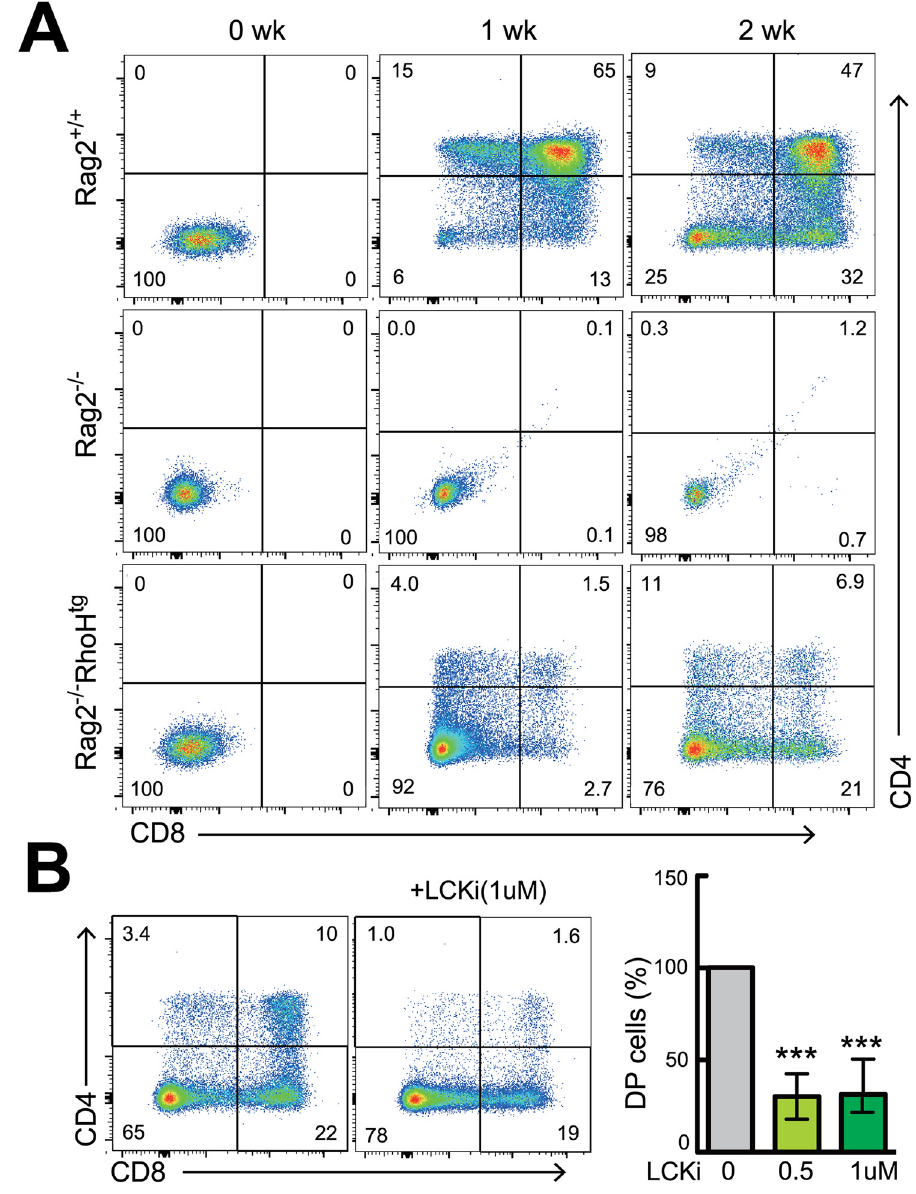
Fig 4. Lck activation is required for RhoH transgene-induced DPs generation without TCR β -gene rearrangement. (A) FACS analysis of the in vitro differentiation of thymocytes to the DP stage. DN3 cells from Rag2 -/- , Rag2 -/- RhoH tg , and Rag2 +/+ C57B6 mice were differentiated for 14 days with the stromal cell line TSt-4/Dll-1 in the presence of IL-7. Representative two parameter plots show CD4 versus CD8 staining on cultured thymocytes at the indicated days. Results shown are from one out of three independent experiments. (B) DN3 cells were cultured with vehicle alone or a pharmacological inhibitor of Lck at the indicated concentration. Bar graphs represent the percentages of DP thymocytes compared with the vehicle control group. Data are representative of more than three independent experiments. *** P <